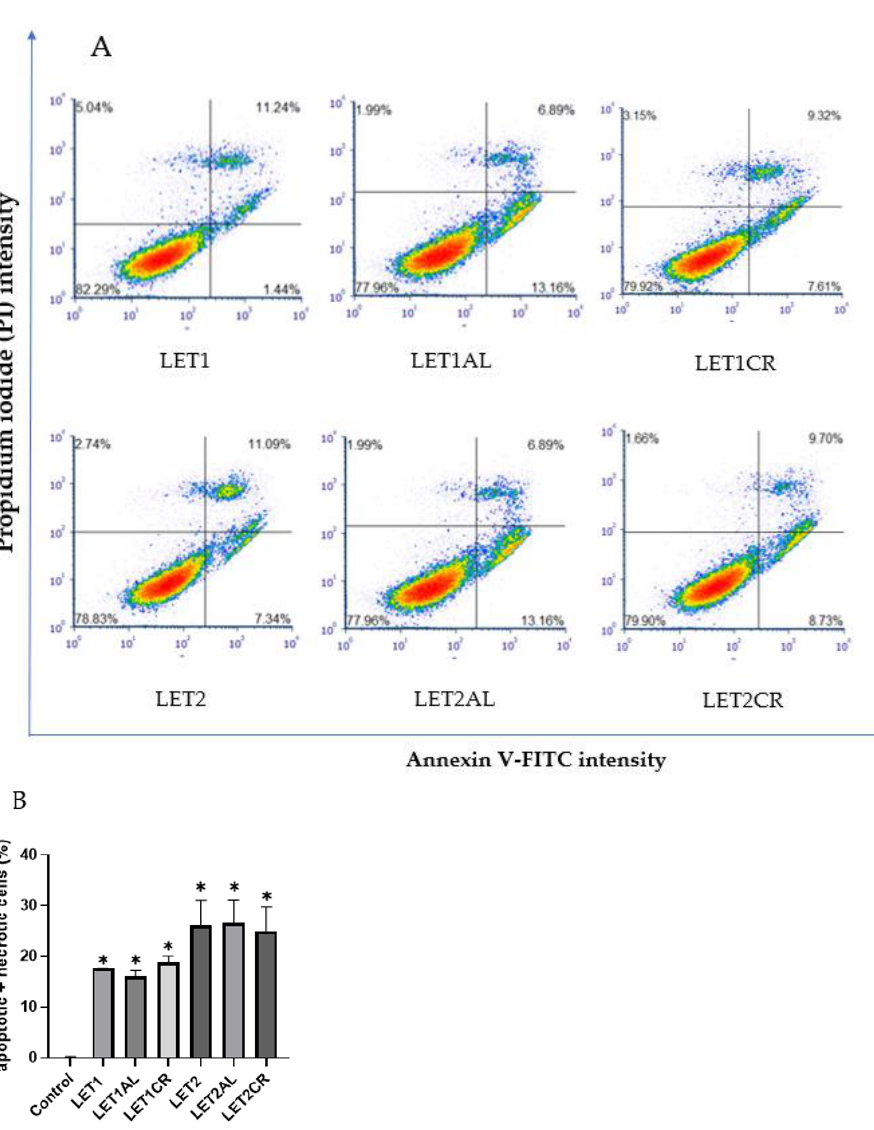
Figure 5. Effect of letrozole alone and in combination with metalloestrogens on MCF-7/DOX cell death. ( A ) Representative cytograms of flow cytometric are shown. LET1 = 10 µM; LET2 = 100 µM; Al./Cr(III) = 100 µM. ( B ) Percentage of both apoptotic (early and late apoptotic) and necrotic cells. The results are presented as mean ± SD, n = 3; p < 0.05; * statistically significant difference from control.